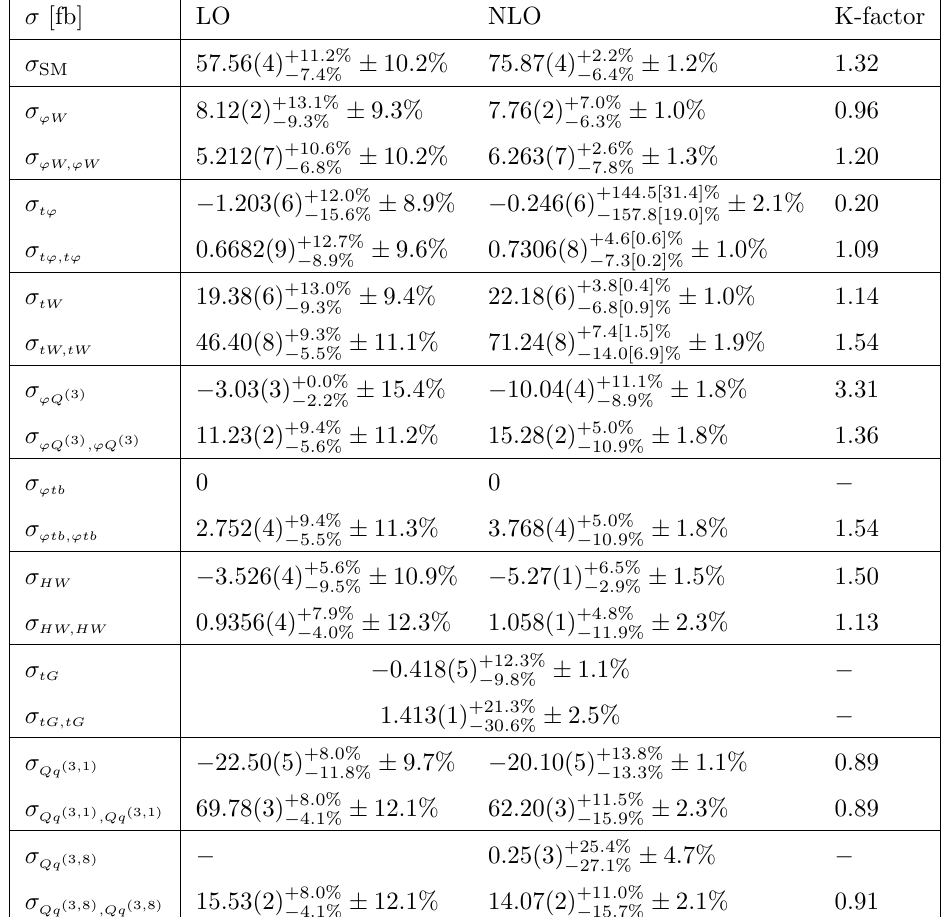
Table 4 . Cross-section results for tHj at 13 TeV, following the parametrisation of eq. ( 4.1). Central values are quoted followed by the upper and lower scale uncertainty bands obtained by varying the renormalisation scale between half and twice the central value, the EFT scale uncertainty where relevant and (cid:12)nally the PDF uncertainty. The MC error on the last digit is shown in the bracket.